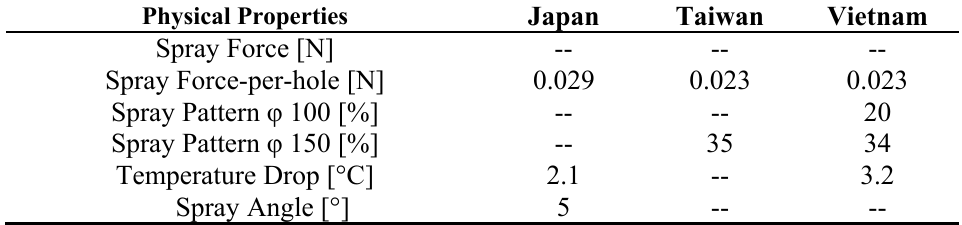
Table 6. Comparison of Group value among three